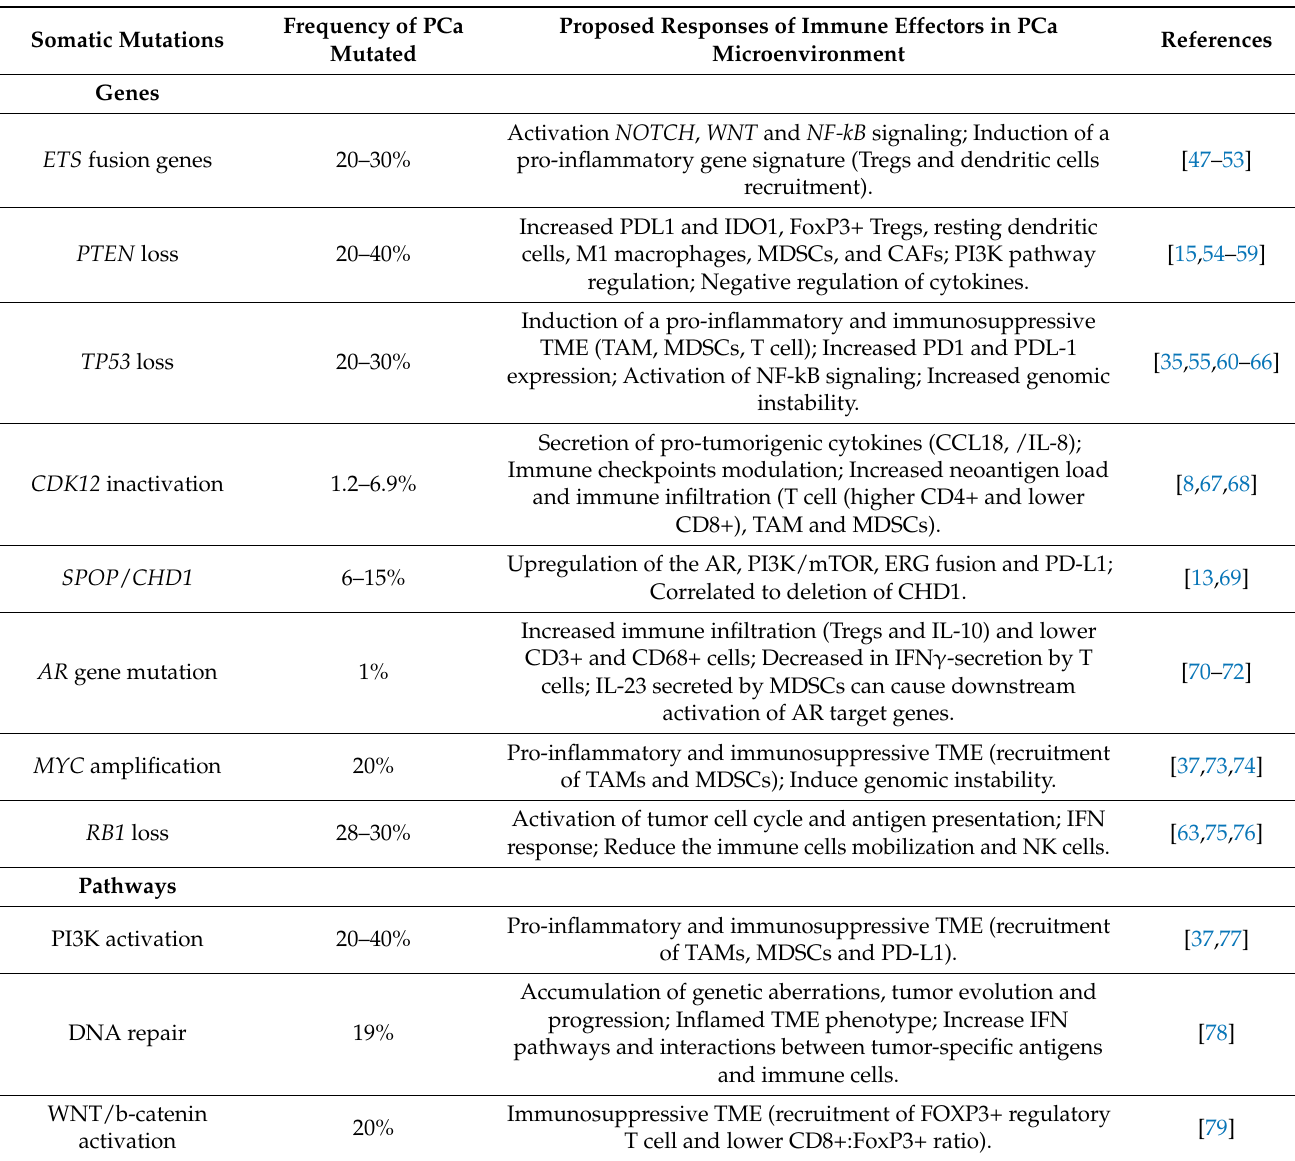
Table 1. Somatic mutations and immune response in PCa